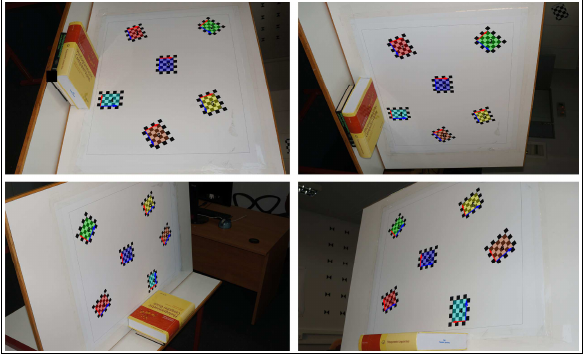
Figure 12. Details of Sony images showing all pattern correspondences established across